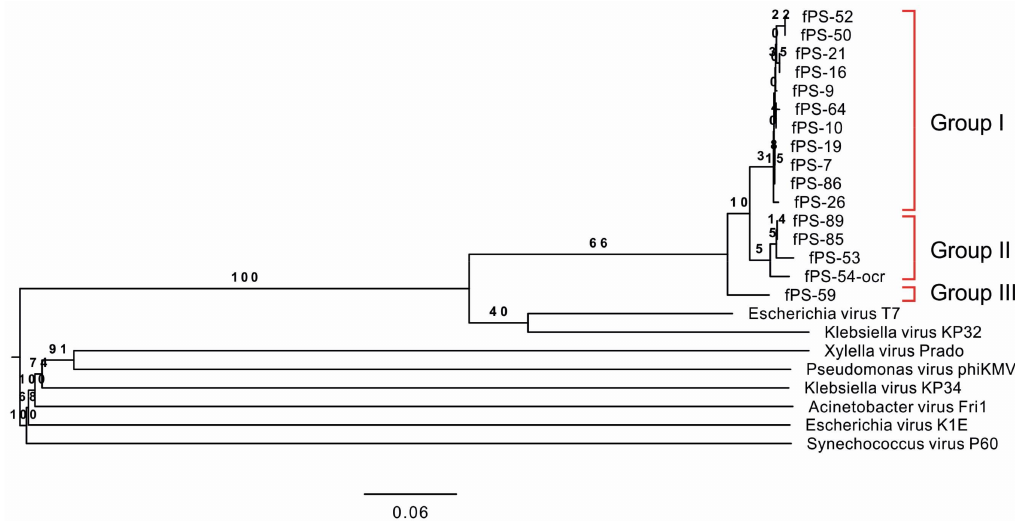
Figure 3. Phylogenetic tree generated by VICTOR using the complete genomic sequences of the fPS-phages and eight phage species, that were chosen to represent the eight genera of the Autographivirinae subfamily: Escherichia virus T7 (NC_001604.1), Klebsiella virus KP32 (NC_013647.1), Xylella virus Prado (NC_022987.1), Pseudomonas virus phiKMV (NC_005045.1), Klebsiella virus KP34 (NC_013649.2), Acinetobacter virus Fri1 (KR149290.1), Escherichia virus K1E (KY435490.1) and Synechococcus virus P60 (NC_003390.2). The genetic Groups I–III are indicated by red